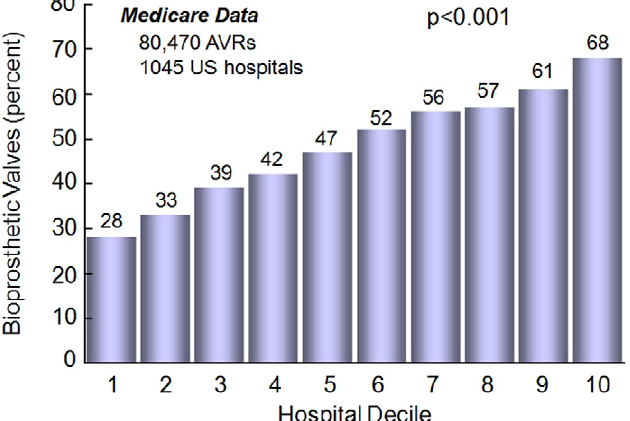
Figure. 6 Rates of aortic valve replacement (AVR) with bioprosthetic valves in patients 65 years and older in the US Medicare system. Patients undergoing AVR higher volume centers were significantly more likely to receive